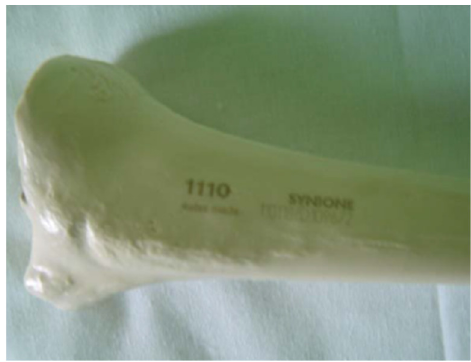
Figure 3. Artificial bone Synbone 1110.